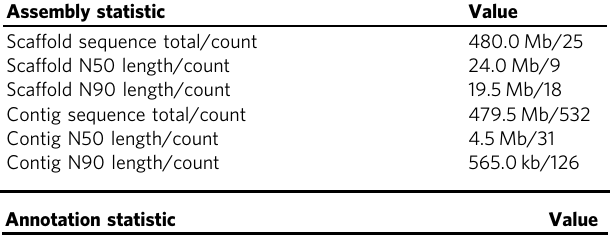
Table 1 Assembly and annotation